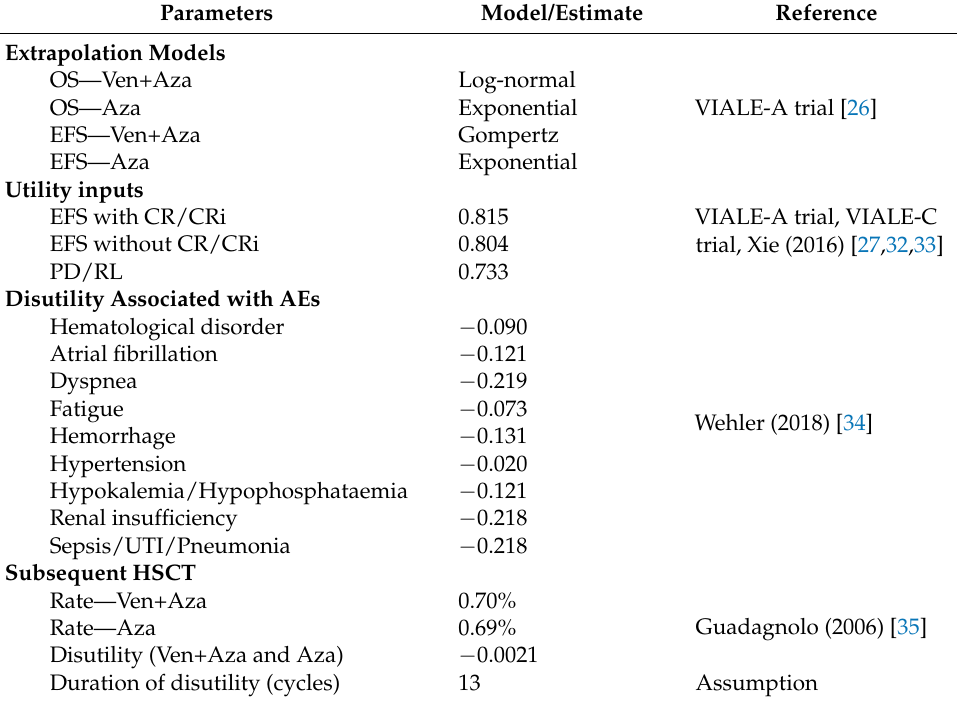
Table 1. Model efficacy